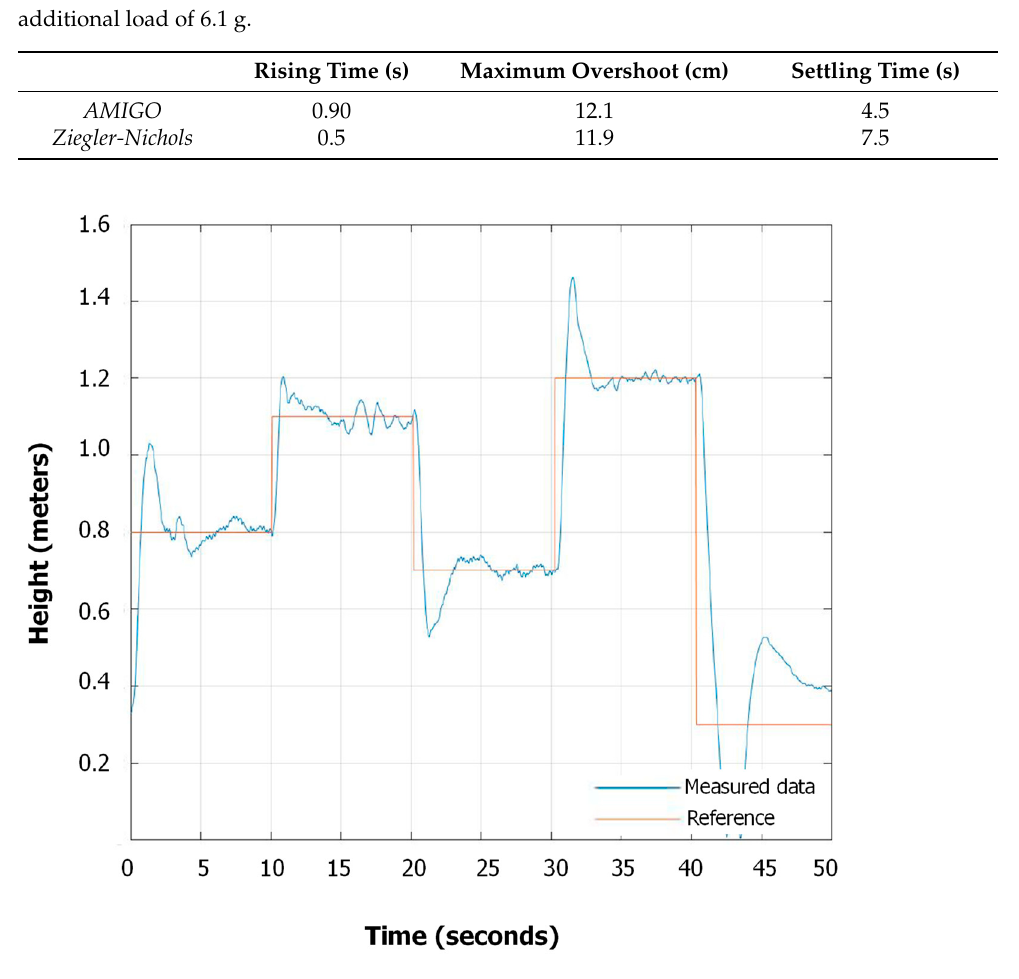
Figure 4. Experimental results when following the predefined trajectory with an additional load of 4.7 g according to the AMIGO method.